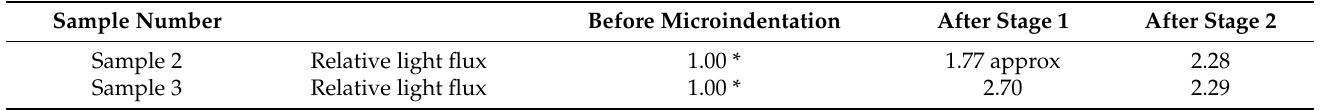
Figure 8. Spectrum of Sample 3 before and after indentation at each stage (normalized at highest 167 peak).